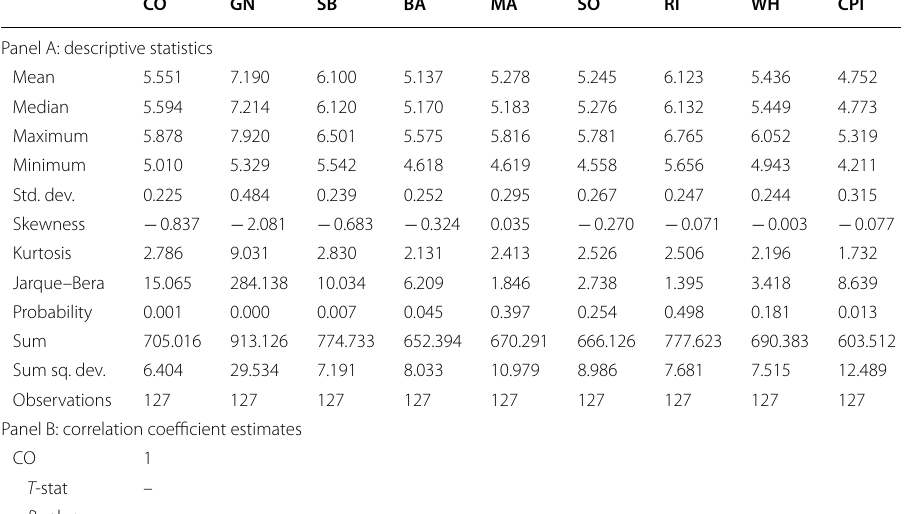
Table 2 Summary statistics and correlation coefficient